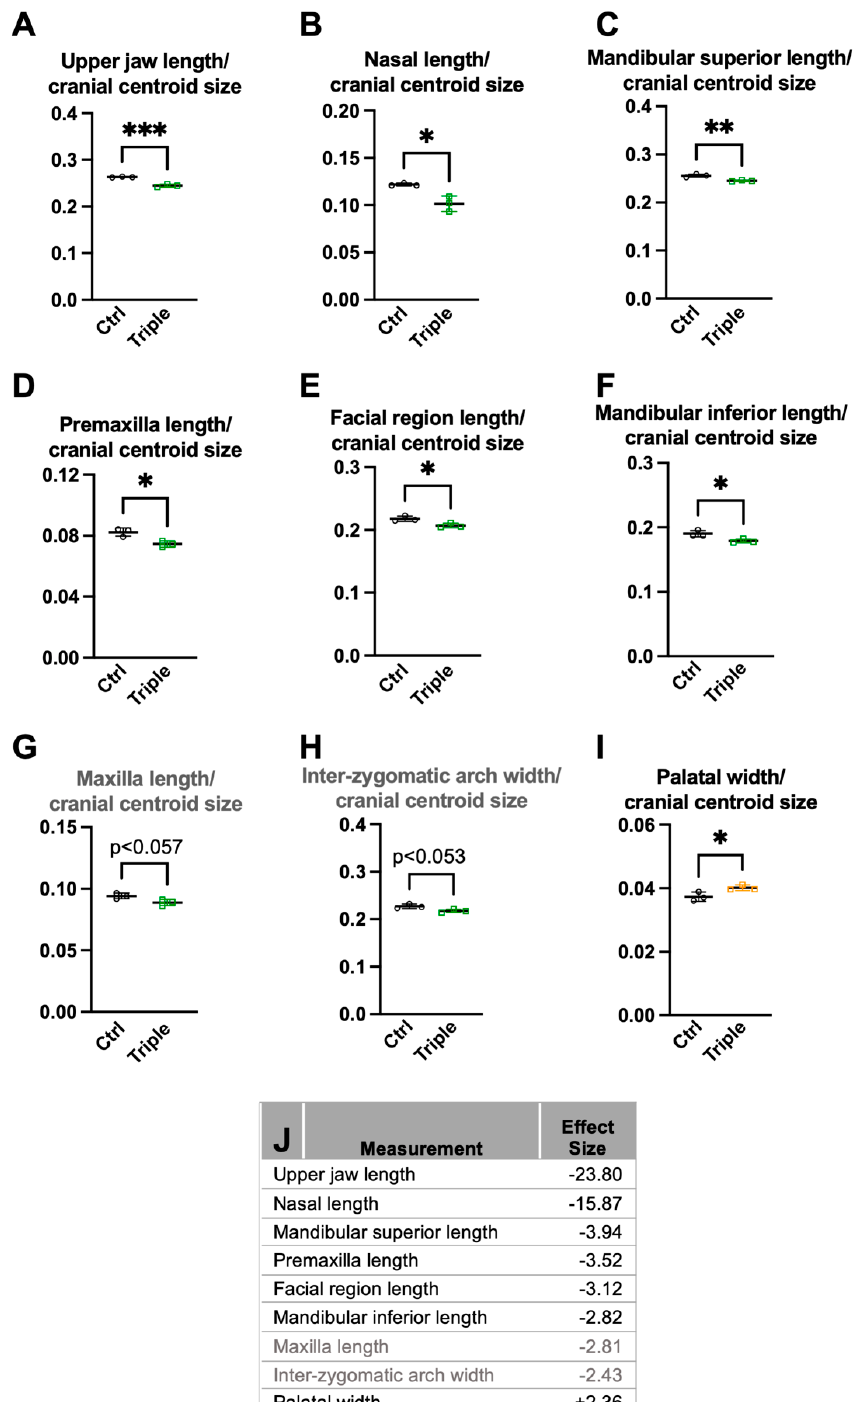
Figure 4. Significantly smaller measurement differences relative to cranium centroid size in Thm2 − / − ; Thm1 aln/+ mice. When correcting for cranium centroid size, triple allele mutant mice have smaller ( A ) upper jaw length; ( B ) nasal length; ( C ) mandibular superior length; ( D ) premaxillary length; ( E ) facial region length; ( F ) mandibular inferior length; ( G ) maxillary length; ( H ) inter-zygomatic arch width; and increased ( I ) palatal width. ( J ) Effect size of measurements in ( A – I ). n = 3 control; n = 3 triple allele mutant. Data points represent individual mice. Bars represent mean ± SD. Statistical significance was determined using unpaired t -tests. * p < 0.05; ** p < 0.01; *** p < 0.001.